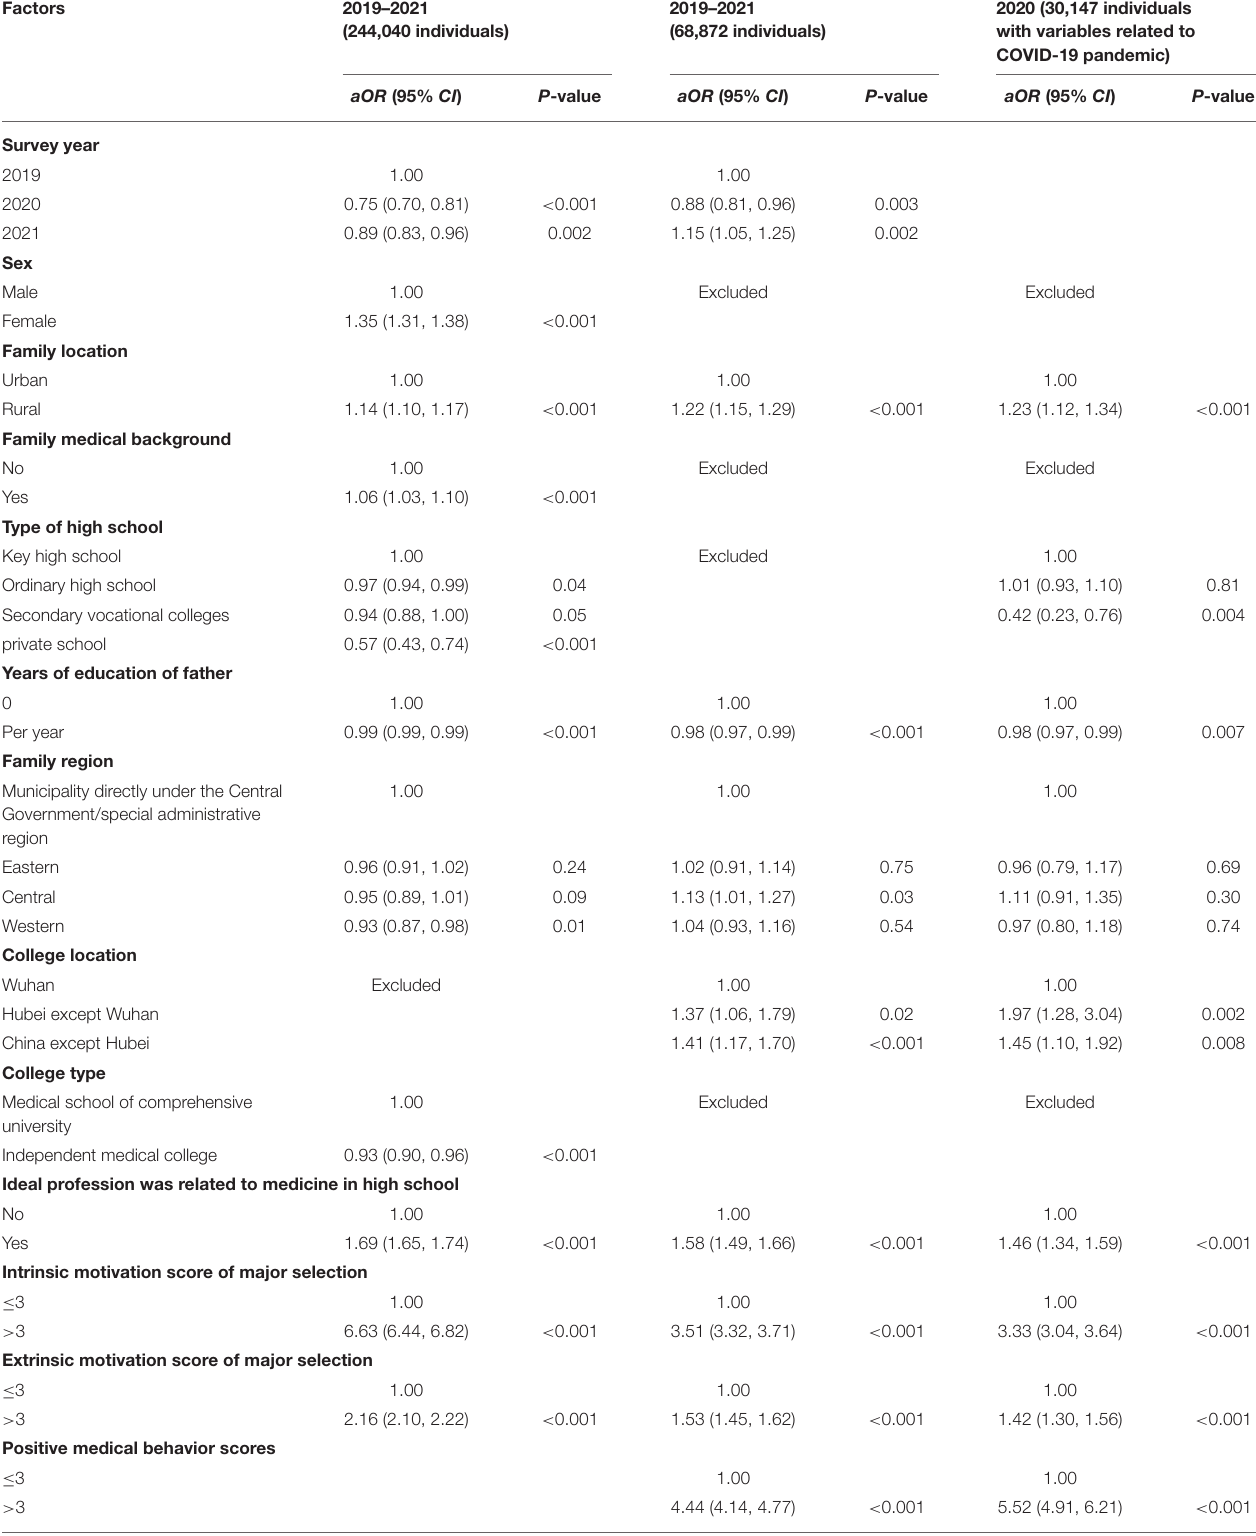
TABLE 3 | Factors influenced professional identity of medical students in China by multivariate logistic regression models.